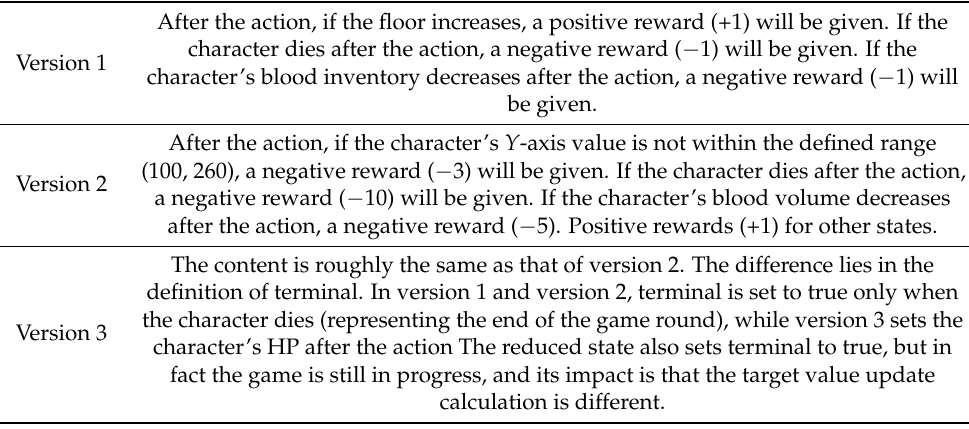
Table 16. The content of reward function.